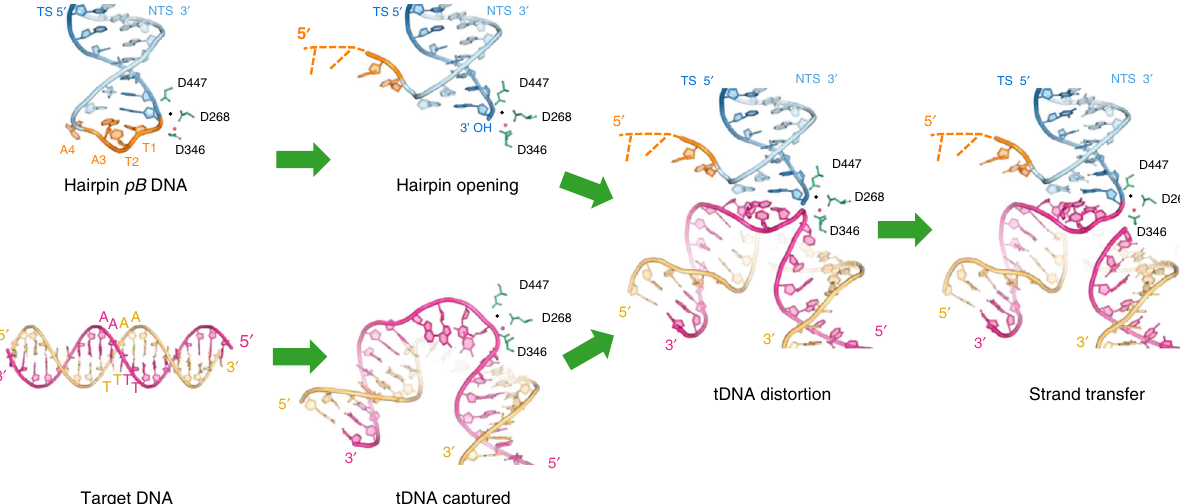
Fig. 7 Model of piggyBac transposition. Upon liberating the transposon from the donor site, PB then catalyzes hairpin DNA opening and integration into a 4-bp TTAA target site. Target DNA is accessed through the minor groove and undergoes a severe bend and distortion. Hairpin opening and target DNA capture may or may not be concerted at the active site. The observed metal ion is shown as a red sphere and a second metal ion as a black sphere. Catalytic residues are shown as green sticks. DNA molecules are colored as in Fig. 1d. NTS non-transferred strand, TS transferred